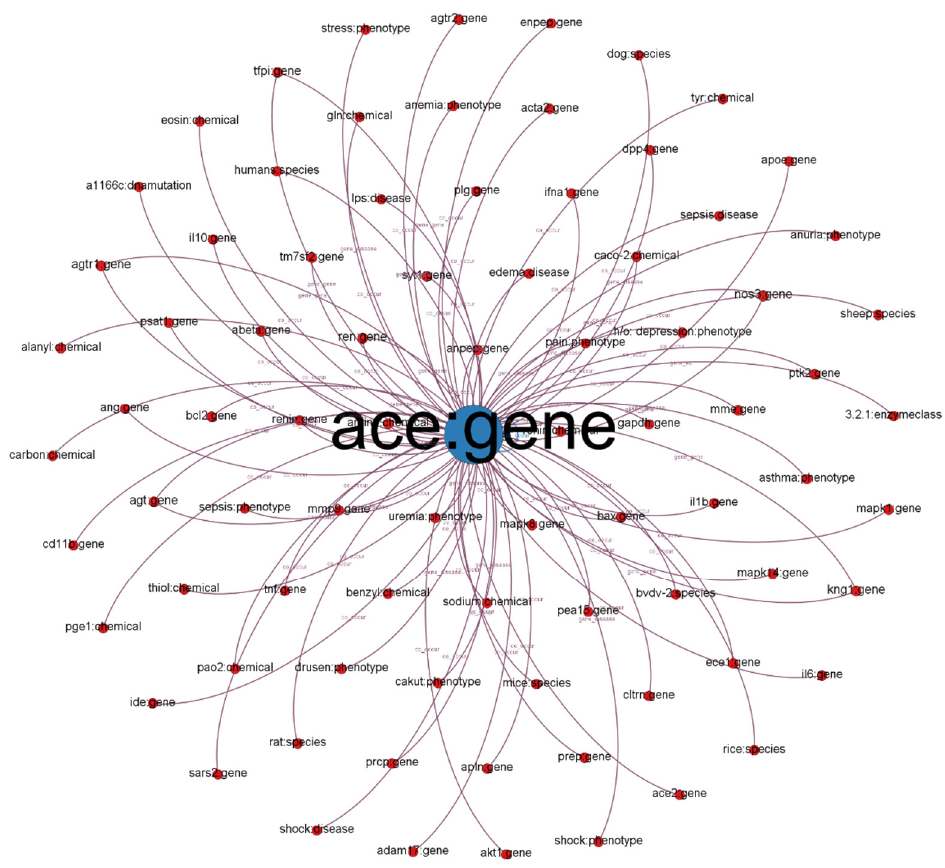
Figure 1. Subgraph from established KG with ACE: gene as the center node.